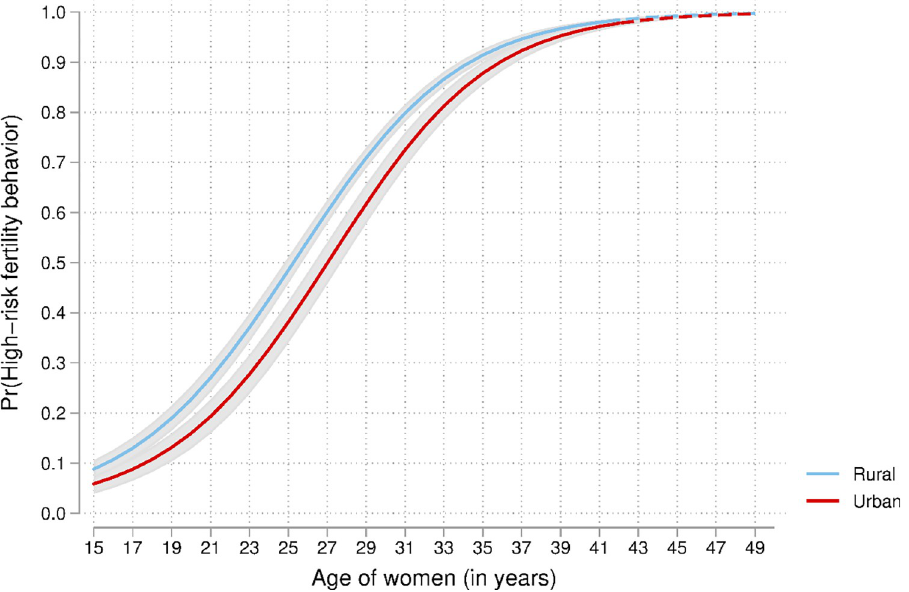
Fig 2. Predicted probability of high-risk fertility behaviour by age and place of residence among married women in the Democratic Republic of the Congo. Note: Group difference (rural vs urban) is significant ( p < 0.05) when lines are